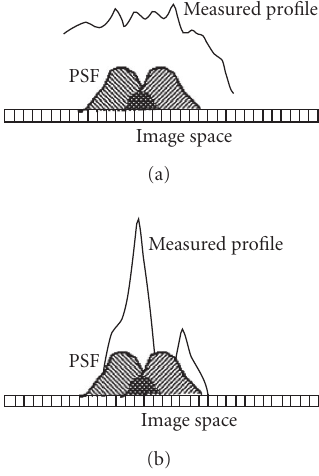
v A > 0 (light grey), is j , such as i , j